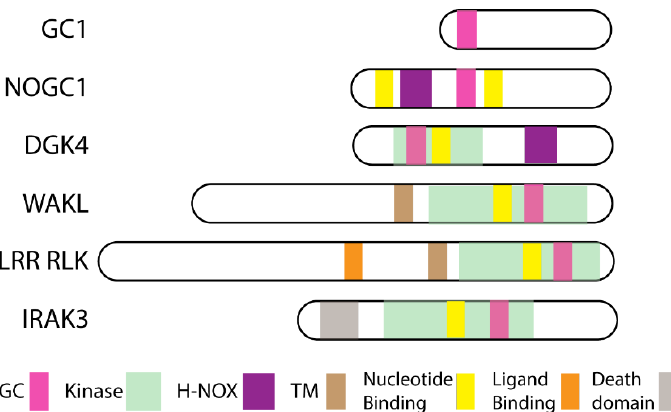
Figure 1. Schematic showing domain architecture of the guanylate cyclases discussed in the text. The guanylate cyclase is depicted in pink, predicted nucleotide binding sites are shown in yellow, kinase domain in pale green, heme-NO/oxygen (H-NOX) domains in purple, transmembrane (TM) domain in brown, ligand binding in orange and the death domain in grey. The schemes are relative to the predicted protein size using the plant leucine rich repeat receptor like kinase (LRR RLK) phytosulfokine receptor (PSKR1) receptor as the reference. The proteins are all plant proteins (GC1 refers to guanylate cyclase 1, NOGC1 as nitric oxide GC1, DGK4 is diacylglycerol kinase 4, and WAKL is wall associated kinase like) except interleukin receptor 1 associated kinase 3 (IRAK3) which is a mammalian protein. IRAK3 contains a kinase homology domain (pseudokinase) differing from LRR RLK, WAKL, and DGK4 which are active kinases.